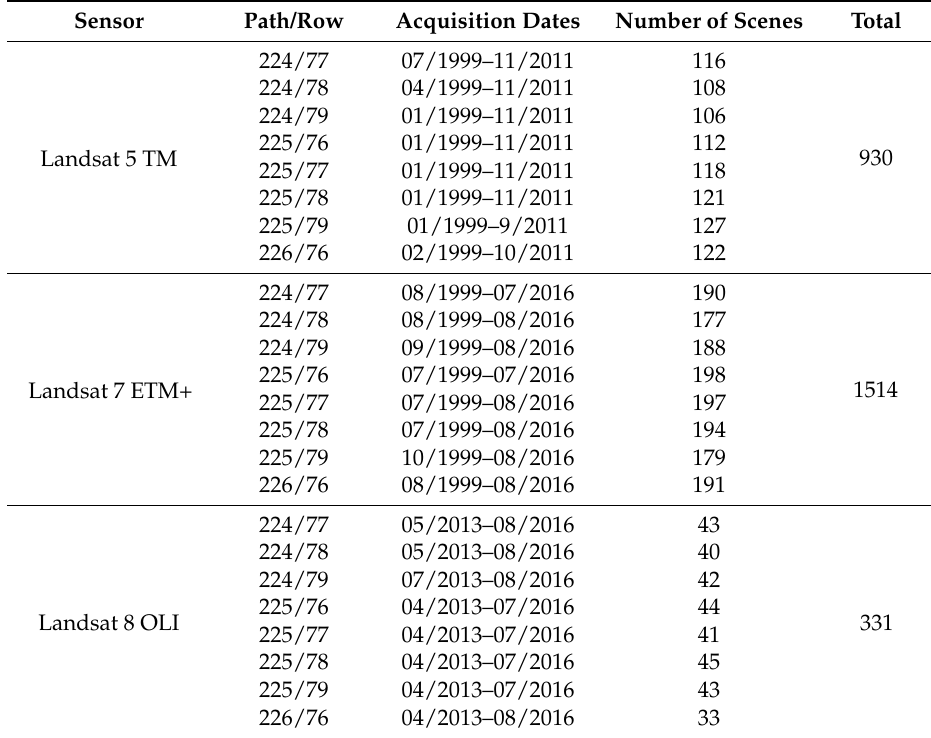
Table 1. Landsat data and number of processed scenes used in this